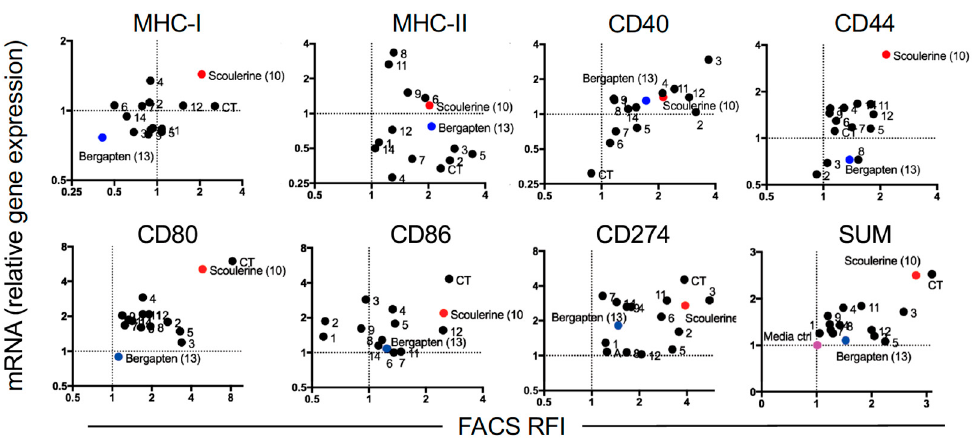
Figure 3. Correlation of modulation of mRNA and protein expression of immune molecules by plant compounds. The up-regulated and down-regulated gene expression induced by compounds falls in the upper right quadrant and the lower left quadrant, respectively. Scoulerine ( 10 ) and bergapten ( 13 ) are labeled red and blue circles, respectively. Other compounds tested are labeled as black circles. Culture media is labeled as a pink circle.